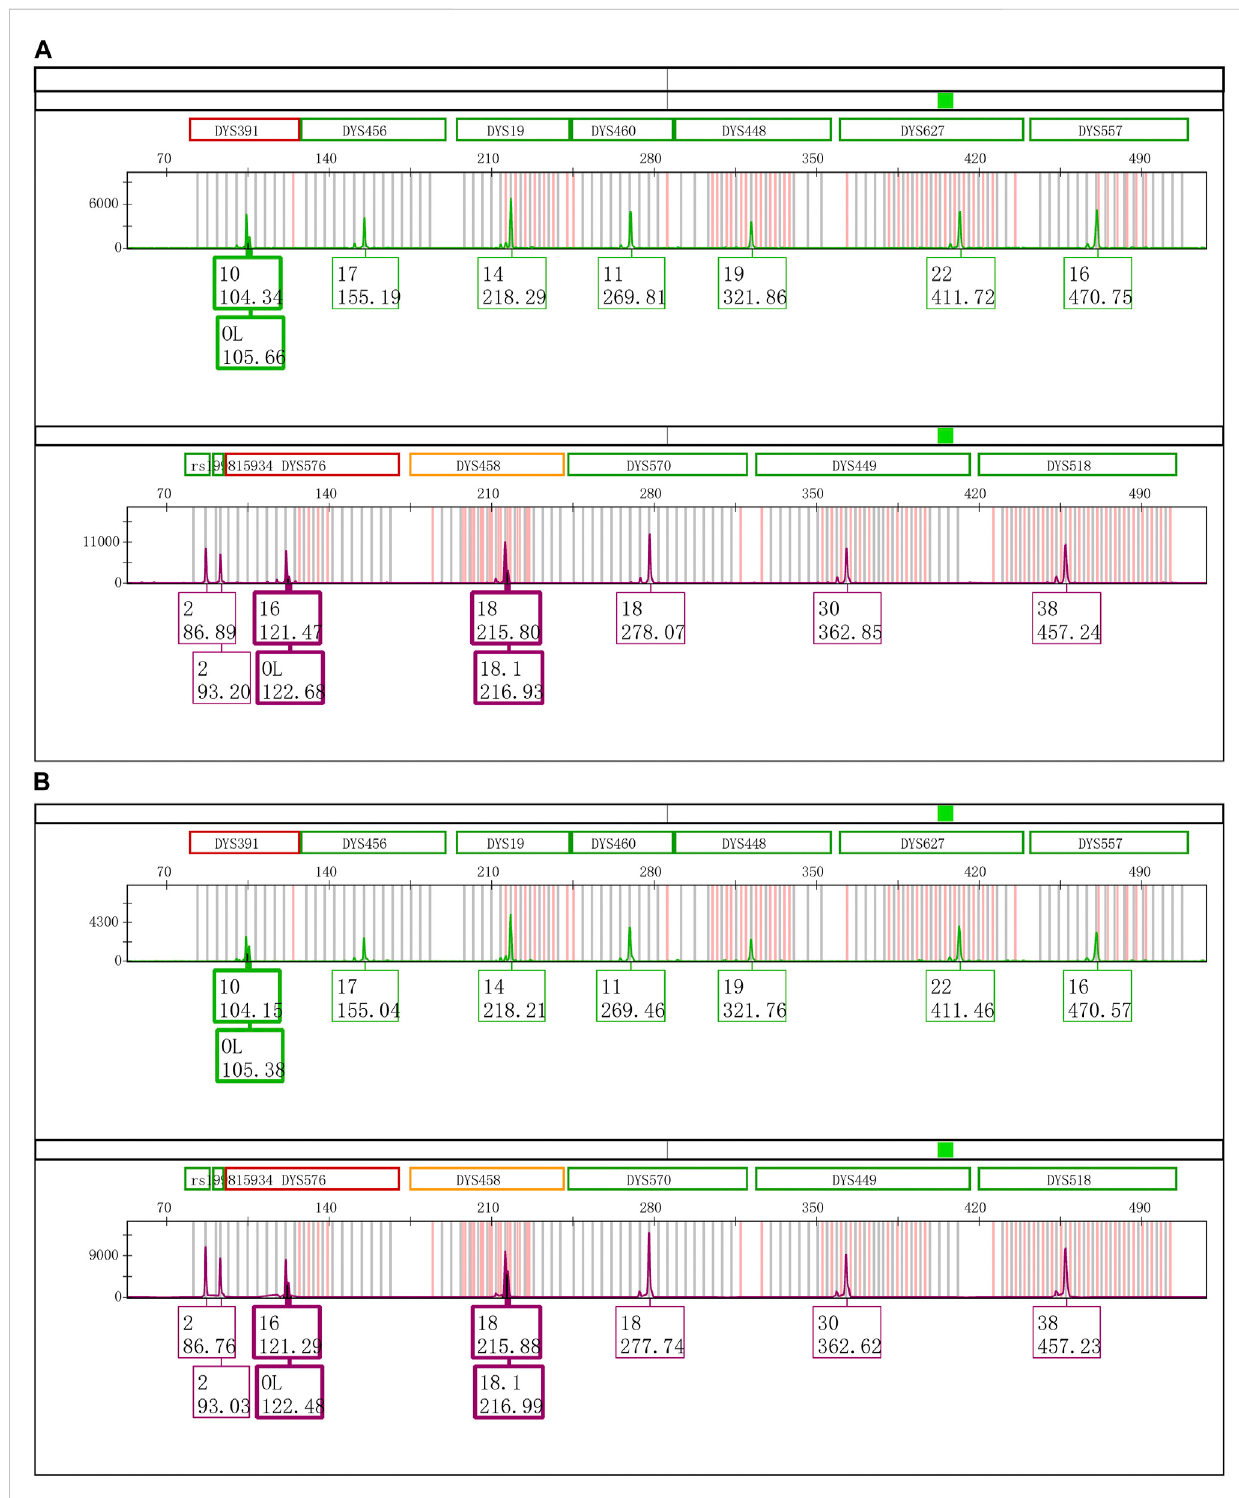
Electrophoretogram results of the green and purple dye channels in Y43CS. (A) The extra peaks appeared at loci DYS391, DYS576 and DYS458 after the PCR products stored6 days at4 ° C. The peak height ratios ofextra peaks to true alleles atthe three loci were 0.3413, 0.2037 and 0.3089, respectively. (B) The extra peaks appeared at loci DYS391, DYS576 and DYS458 after the PCR products stored 1 day at room temperature. The peak height ratios of extra peaks to true alleles at the three loci were 0.6061, 0.3907 and 0.6012,